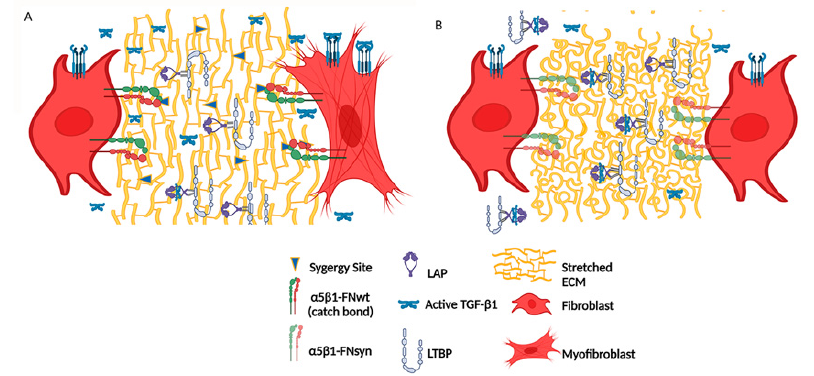
Figure 6. Non-proteolytic TGF- β 1 activation in the granulation tissue of Fn1 +/+ ( A ) and Fn1 syn/syn wounds ( B ). (A) TGF- β 1 is secreted non-covalently bound to the LAP-LTBP complex and is stored on FN-containing ECMs. In Fn1 +/+ wounds as the ECM stiffness increases upon skin injury, FN binding cells increase traction forces on FN through synergy site catch bond formation with α 5 β 1 integrins. TGF- β 1 is activated by its liberation from the latent complex and binds TGF- β 1-receptors at the fibroblast membrane inducing myofibroblast conversion. ( B ) In Fn1 syn/syn wounds ECMs are less stretched trapping less TGF- β 1-LAP-LTBP latent complexes, and pulling forces mediated by FN- α 5 β 1 bonds are reduced with the consequent decrease in TGF- β 1 release and signalling. In summary, our results show that the loss of FN synergy site leads to normal wound Supplementary Materials: The following supporting information can be downloaded at: https: closure in vivo, caused by two opposing migratory defects of activated keratinocytes in conjunction with changes in the GT that imply reduced fibrotic response due to weakened and Fn1 syn/syn mice back wounds at 0, 4, 7, 9 and 15 days after wounding (daw). Figure S2: Repre- α 5 β 1-mediated adhesions and poorly assembled FN syn fibrils. In this context, peptides or sentative images from Keratin-6 and keratin-14 (green) staining at 4 daw of Fn1 +/+ and Fn1 syn/syn antibodies that block the FN synergy site may serve as a potential antifibrotic tool in heal- mice back wounds. Scale bar, 200 µ M. Figure S3: Characterization of keratinocyte cell line. Figure S4: ing wounds. Keratinocyte collective